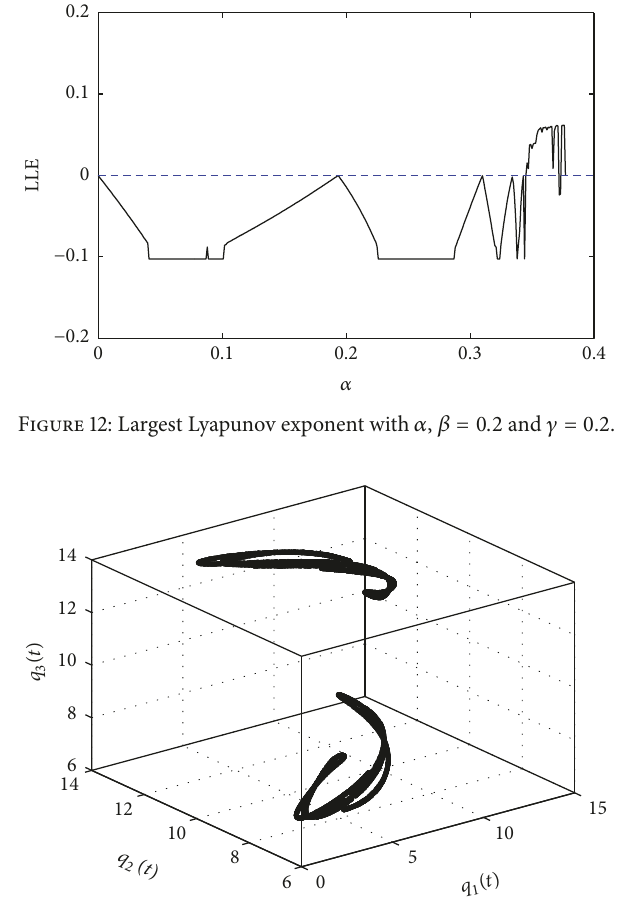
Figure 13: The chaotic attractor of system (7) with 𝛼 = 0.36 , 𝛽 = 0.2 , and 𝛾 = 0.2 .